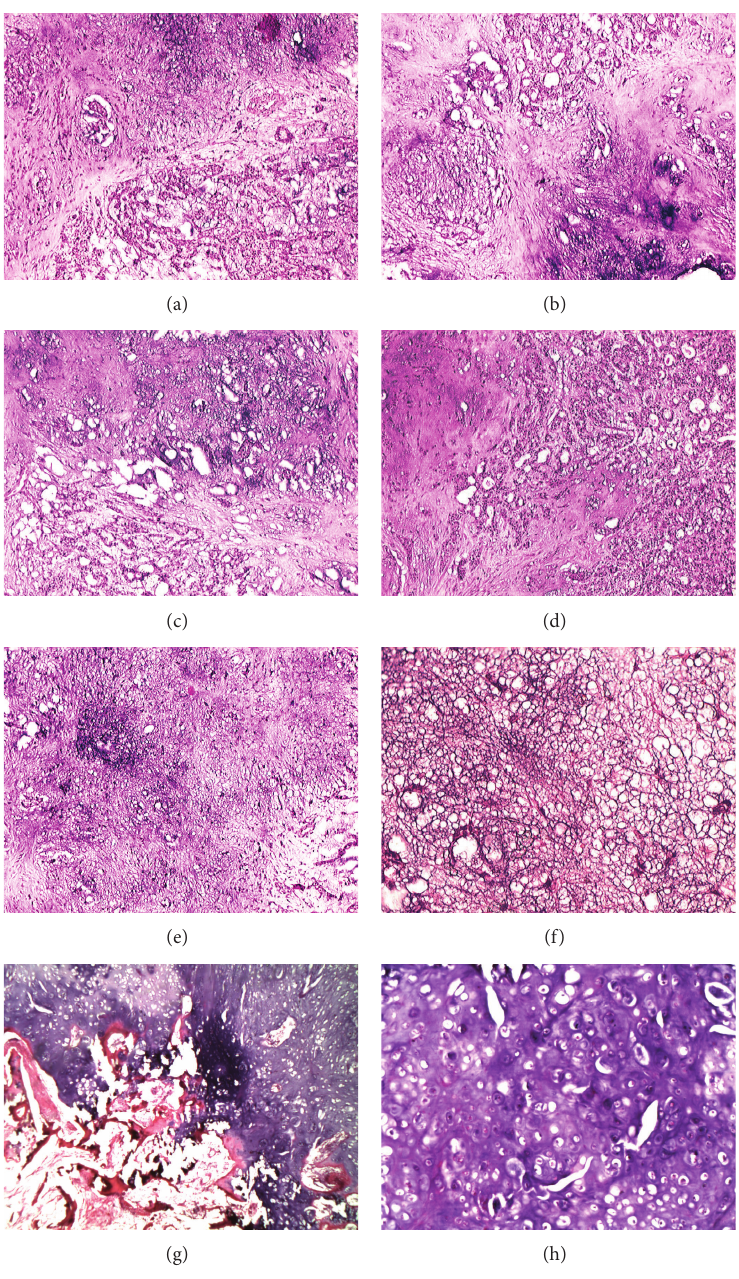
Figure 1: (a) and (b) Two components of PA, epithelial structure with glandular pattern and mesenchymal structure containing chondroid tissue and calcification. (c) Epithelial and mesenchymal components. (d) Predominance of epithelial component with glandular pattern. (e) Predominance of mesenchymal component with chondroid pattern. (f) Predominance of mesenchymal component with myxoid pattern. (g) Myxochondroid and osteoid pattern. (h) Mesenchymal component with predominance of chondroid tissue.